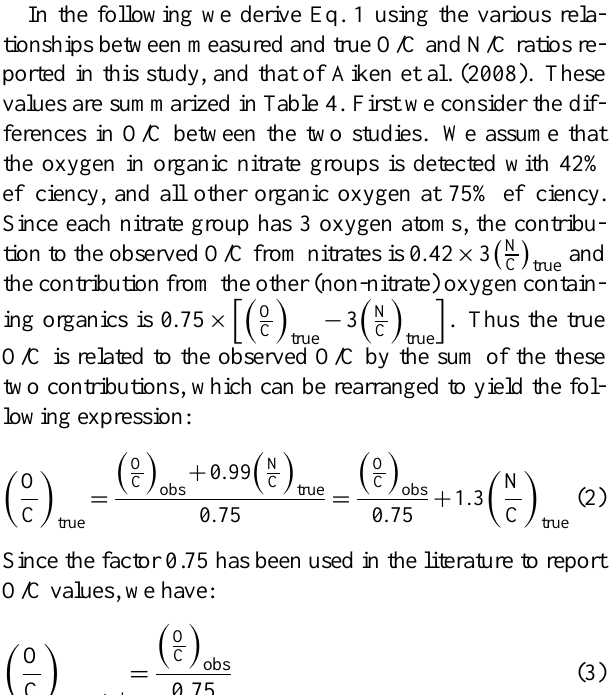
this study, Sect.